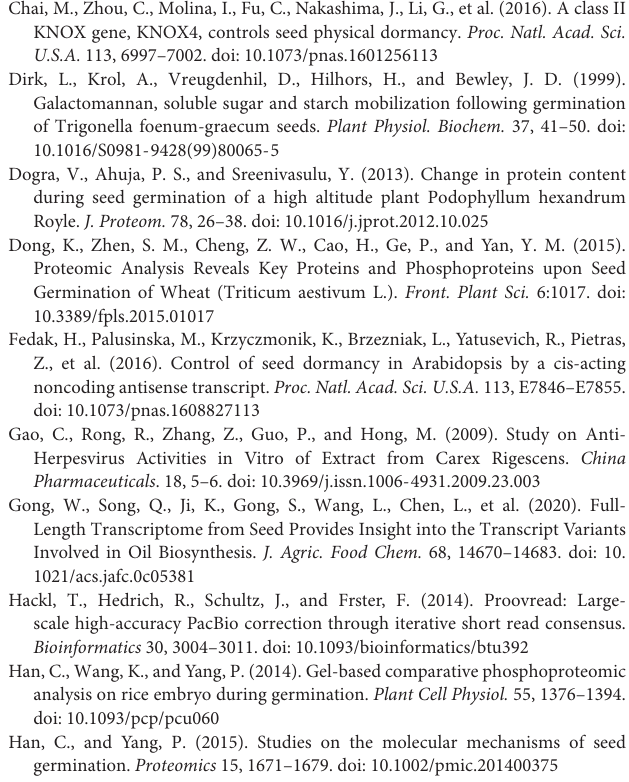
Supplementary Figure 1 | Single molecular real time (SMRT) sequence length distribution. (A) Circular consensus (CCS) read length distribution for 1-6K size bin. (B) The distribution of full passes of each cDNA database. (C) Full-length non-chimeric (FLNC) sequences read length distribution for F01 size bin. (D) Consensus isoforms read length distribution for F01 size